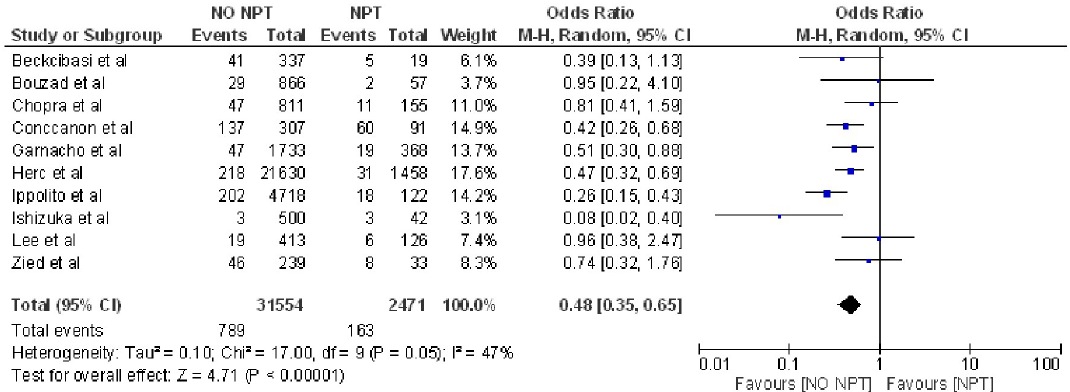
Fig 2. Forest plot of total parenteral nutrition (TPN) and CLABSI.